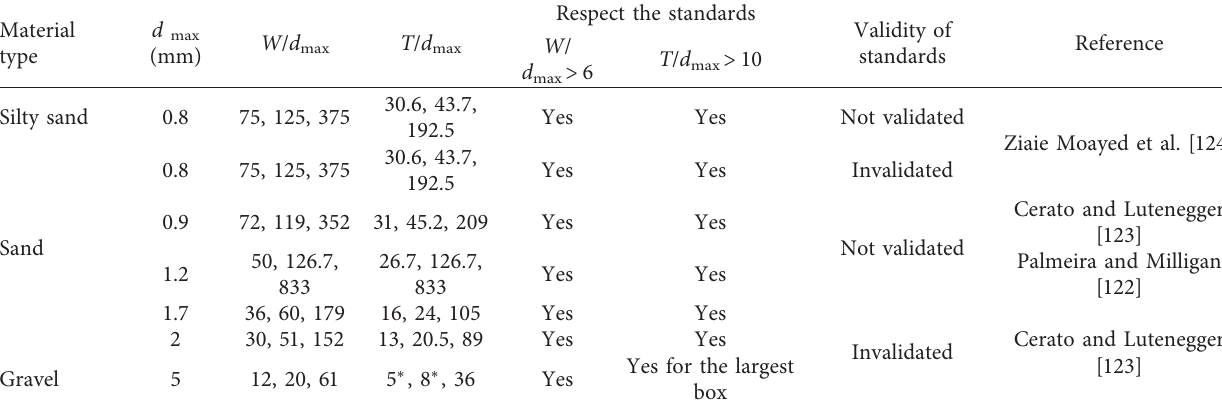
Table 4: Summary of the previous studies on the specimen size effects of friction angle of granular materials.